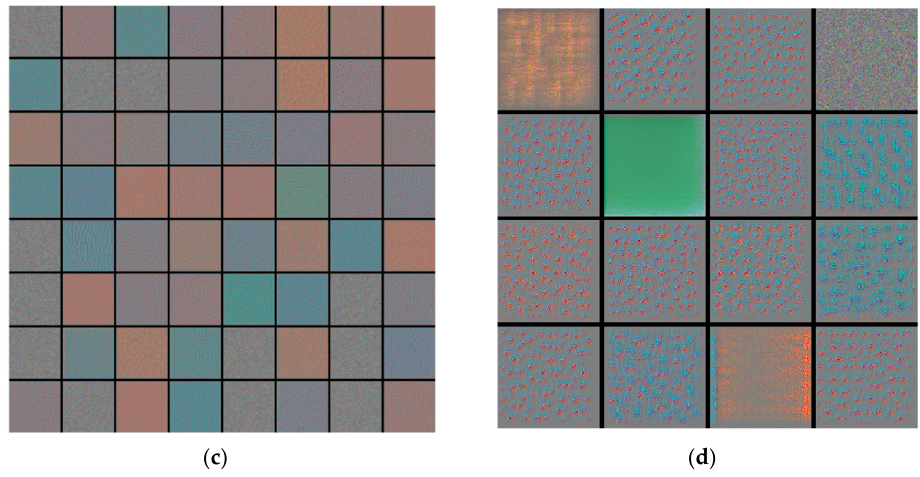
Figure 6. Visualizing learned convolutional filters: ( a ) Convolutional filters of CONV1; ( b ) Convolutional filters of CONV2; ( c ) Convolutional filters of CONV3; ( d ) Convolutional filters of CONV4.